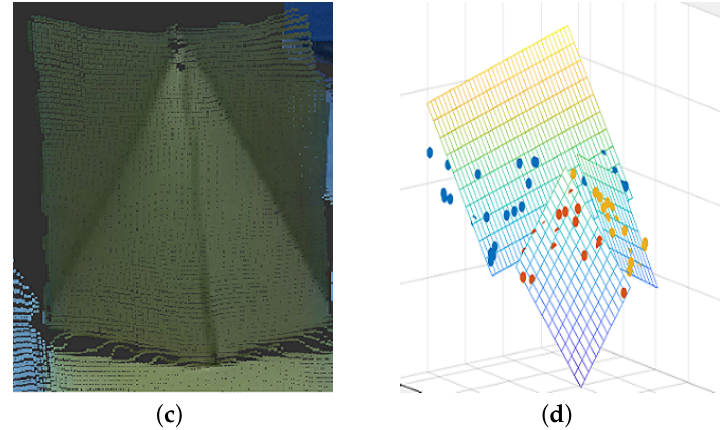
Figure 7. Features of depth camera extraction and fitting. ( a ) Depth camera observation position. ( b ) Depth camera point cloud. ( c ) 3D point cloud of calibration plate features. ( d ) 3D point cloud plane fitting of calibration plate.